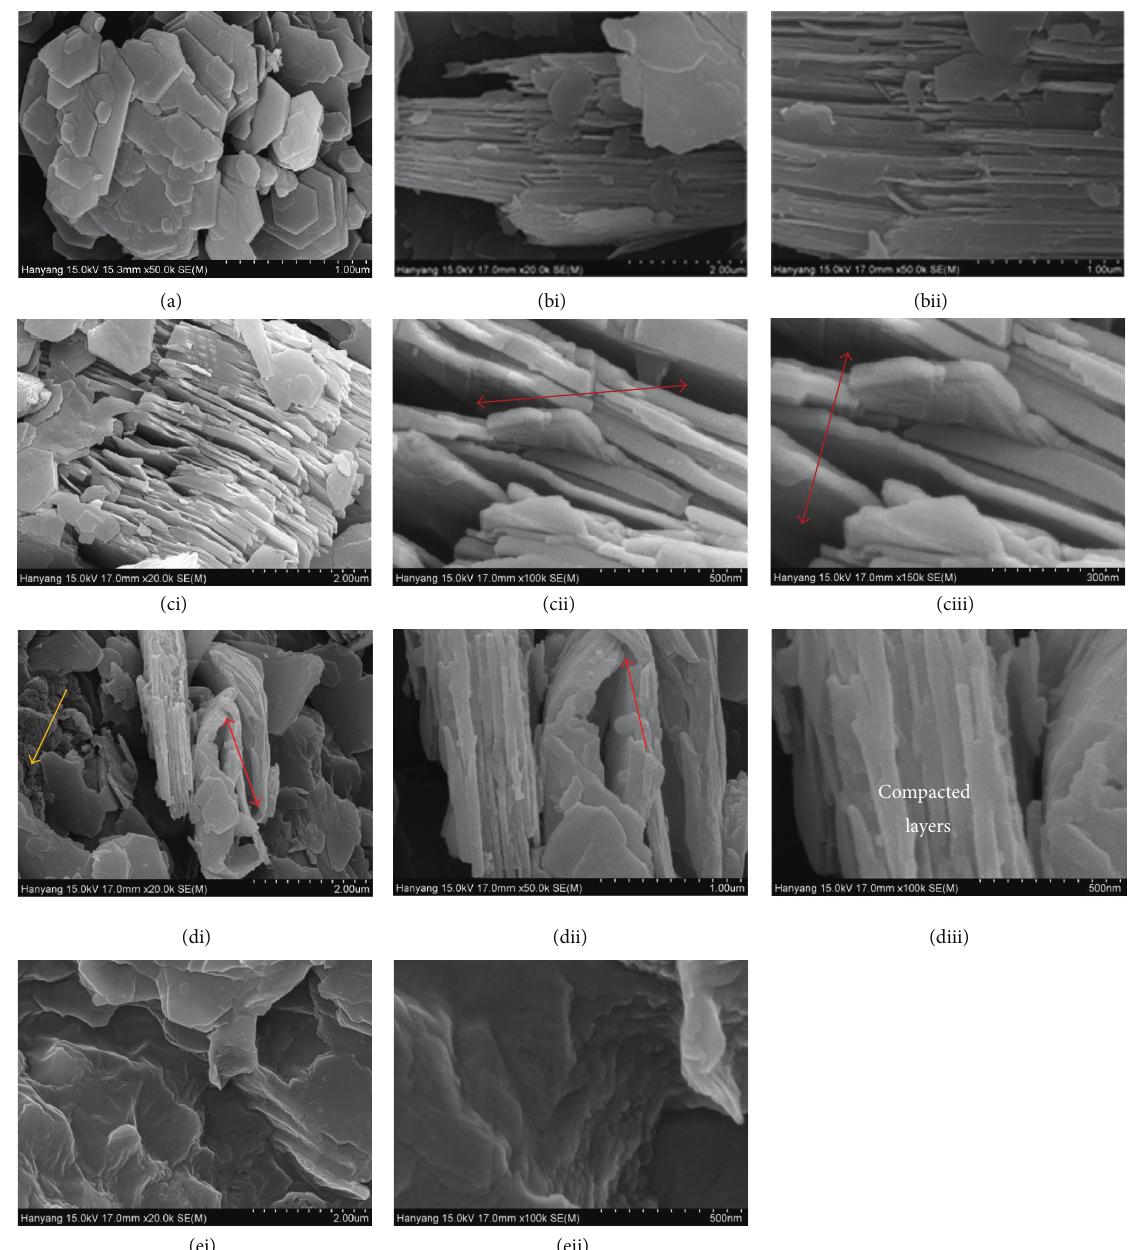
Figure 4: SEM images for (a) beneficiated Pugu kaolinite (KKK), (b) NaKP, (c) KPDMSO, (d) KPDM, and (e) KPDMU.